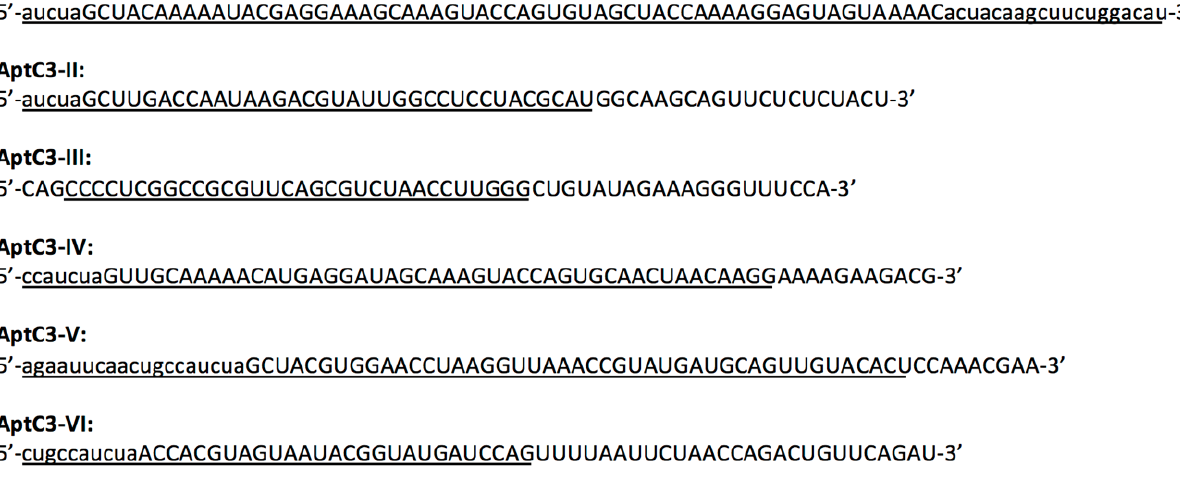
Figure 1. Six distinct aptamers for C3 and its derivatives. Sequences for six 2’-F Py RNA aptamers are presented under their names. For clarity, only the variable region (in uppercase) and the relevant constant regions (in lowercase) are shown. The full-length sequences are given in Materials and Methods. Among multiple isolates of the same aptamer, some harbor point mutations. The sequences shown are the predominant form used in binding assays. Underlined sequence of each aptamer indicates a shorter version that retained binding activity and is portable as a modular domain in the construction of bi-functional composites. When the minimized version was synthesized by in vitro transcription, a GGG tri-nucleotide sequence was added at the 5’ end to form a transcription start site, and a CCC tri-nucleotide is often added at the 3’ end to stabilize the stem. These aptamers would be used as utility aptamers in the bi-functional molecular adap- tors. To investigate the binding affinity and specificity of the six aptamers, electrophoretic mobility shift assays (EMSA) and filter binding assays with radioactively labeled full-length RNA aptamers were performed. The dissociation constants of these aptamers are in the range of 10–60 nM. As an example, the K d of the aptamer AptC3-III (which was chosen later for cell viability assays) was 17 nM for C3, and 14.5 nM for iC3b (Figure 2A). Affinities of the other aptamers are summarized in Table A1 of the Appendix